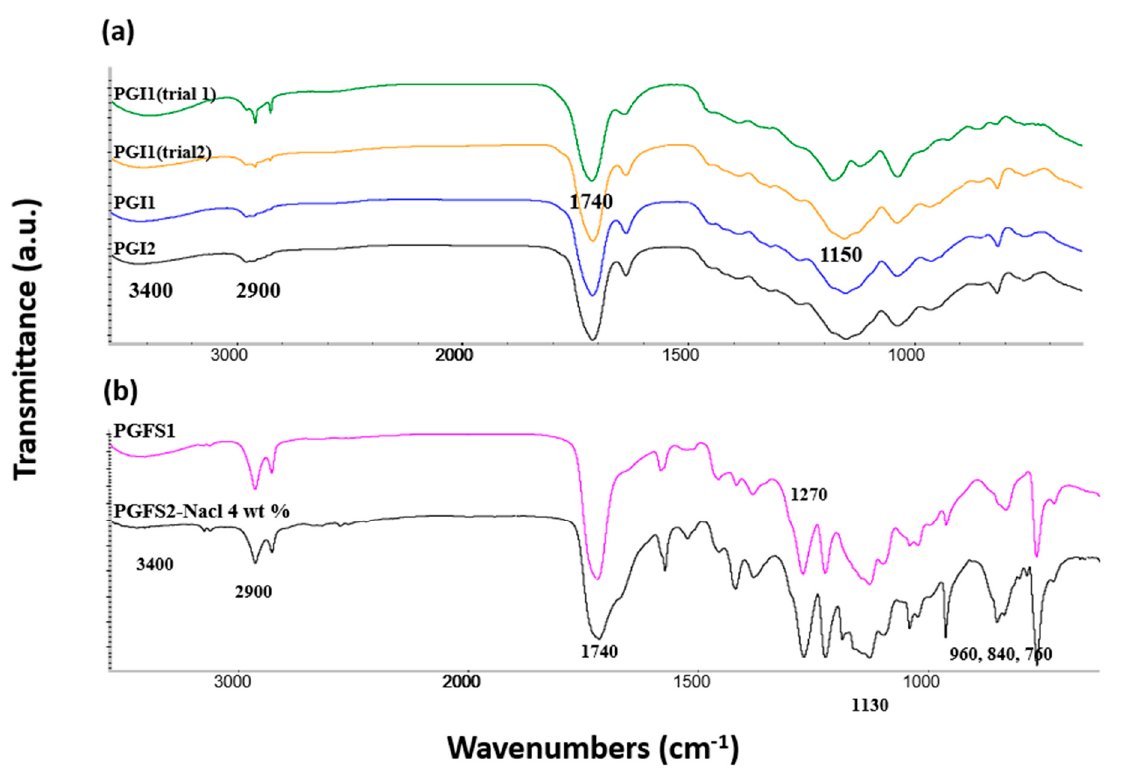
Figure 7. Infrared spectra of elastomer sheets: ( a ) for PGI 1 and 2 (and from prepolymers obtained under microwave irradiation); ( b ) for PGFS1 and 2.